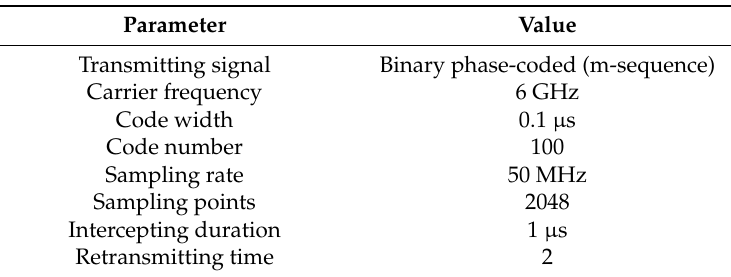
Table 2. Simulation parameters for ISRJ.